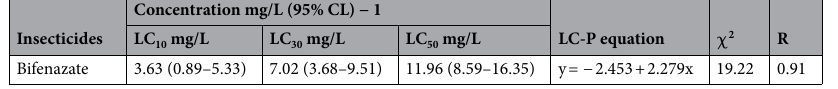
Table1. Toxicity of bifenazate on female adults of Panonychus citri .